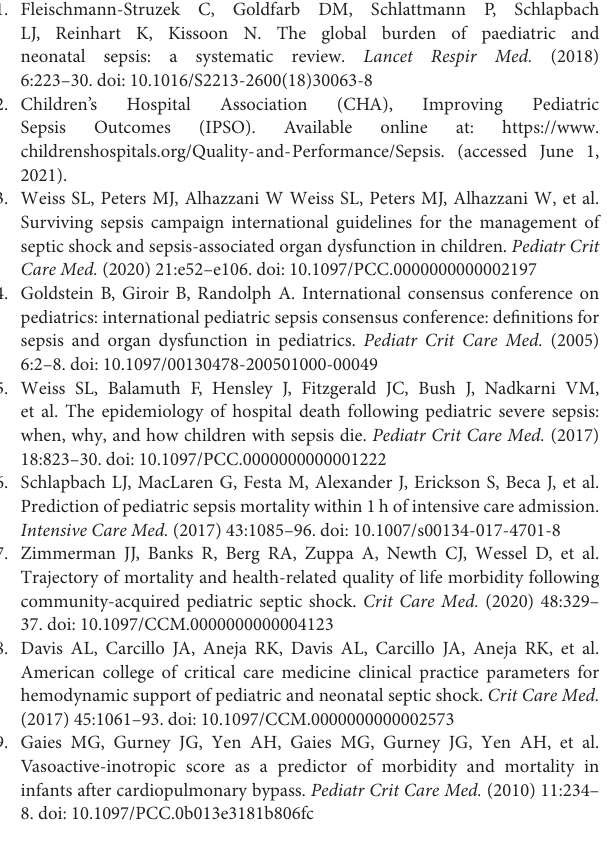
Supplementary Figure 3 | Classification and regression tree analysis for mechanical ventilation days. Supplementary Table 1 | Severe sepsis criteria from the International Consensus Conference on Pediatric Sepsis (4). Supplementary Table 2 | Inclusion and exclusion criteria. ∗ Time 0 is the onset of vasoactive medications. Supplementary Table 3 | Relationship of Aggregate VIS to Hospital Length of Stay at Various Time